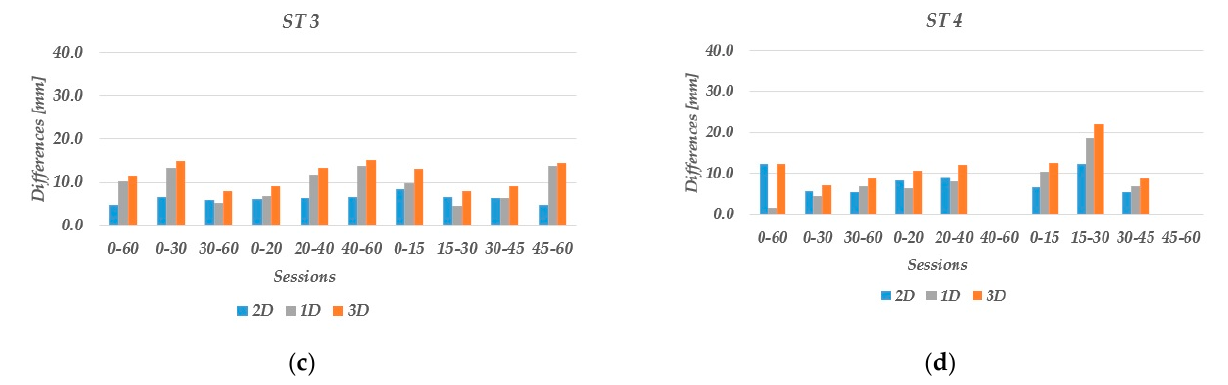
Figure 10. Horizontal, vertical, and spatial positioning accuracy in the open-sky (ST 1) and urban areas (ST 2, ST 3, ST 4): ( a ) LC − 1 at ST 1; ( b ) LC − 1 at ST 2; ( c ) LC − 1 at ST 3; and ( d ) LC − 1 at ST 4.